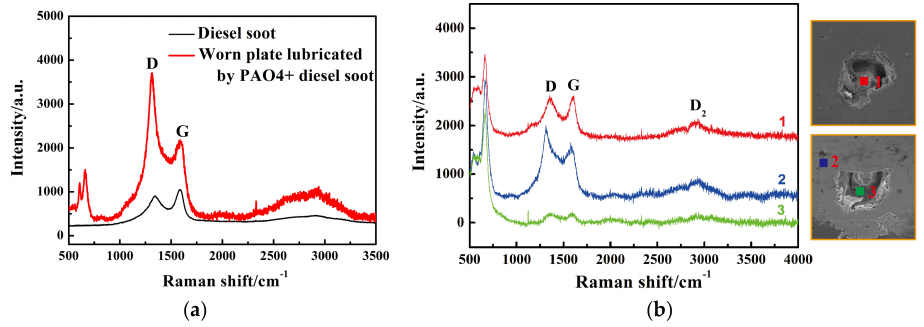
Figure 13. Raman spectra of the worn surfaces ( T = 100 ◦ C): ( a ) DS and the worn surface lubricated by oil + DS; ( b ) The peak in different worn position.